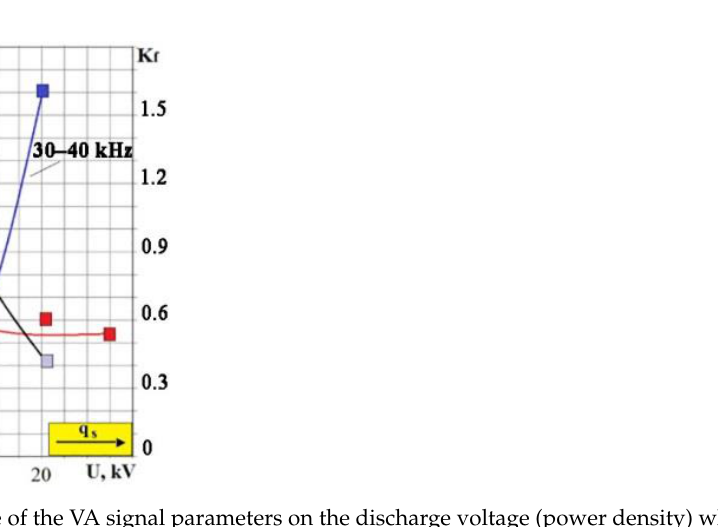
Figure 13. Dependence of the VA signal parameters on the discharge voltage (power density) when irradiating the M20 alloy.